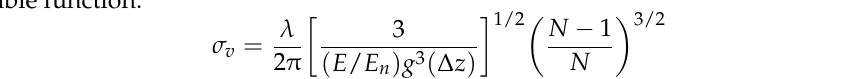
formance cost function of velocity estimation is transformed into a one-variable